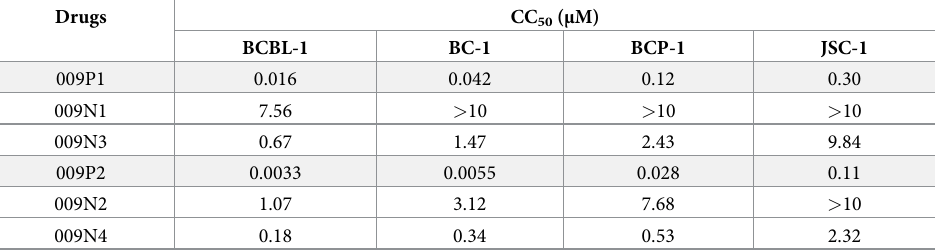
Table 2. Cytotoxicity of 009 stereoisomers against PEL cells.